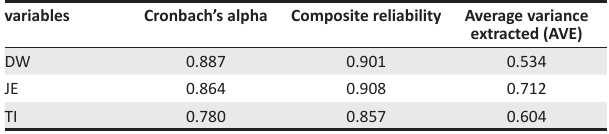
TABLE 1: Descriptive statistics for variables.